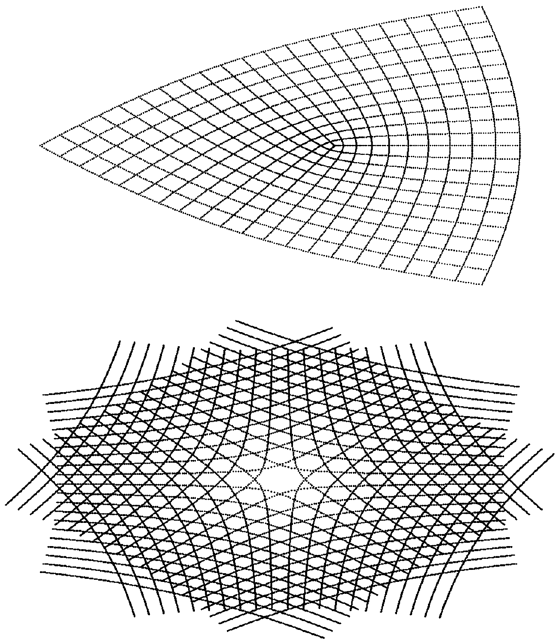
FIG. 2. An angular defect of 90 degrees in a vertex-centered square lattice and an angular excess of 120 degrees in a face- centered kagome